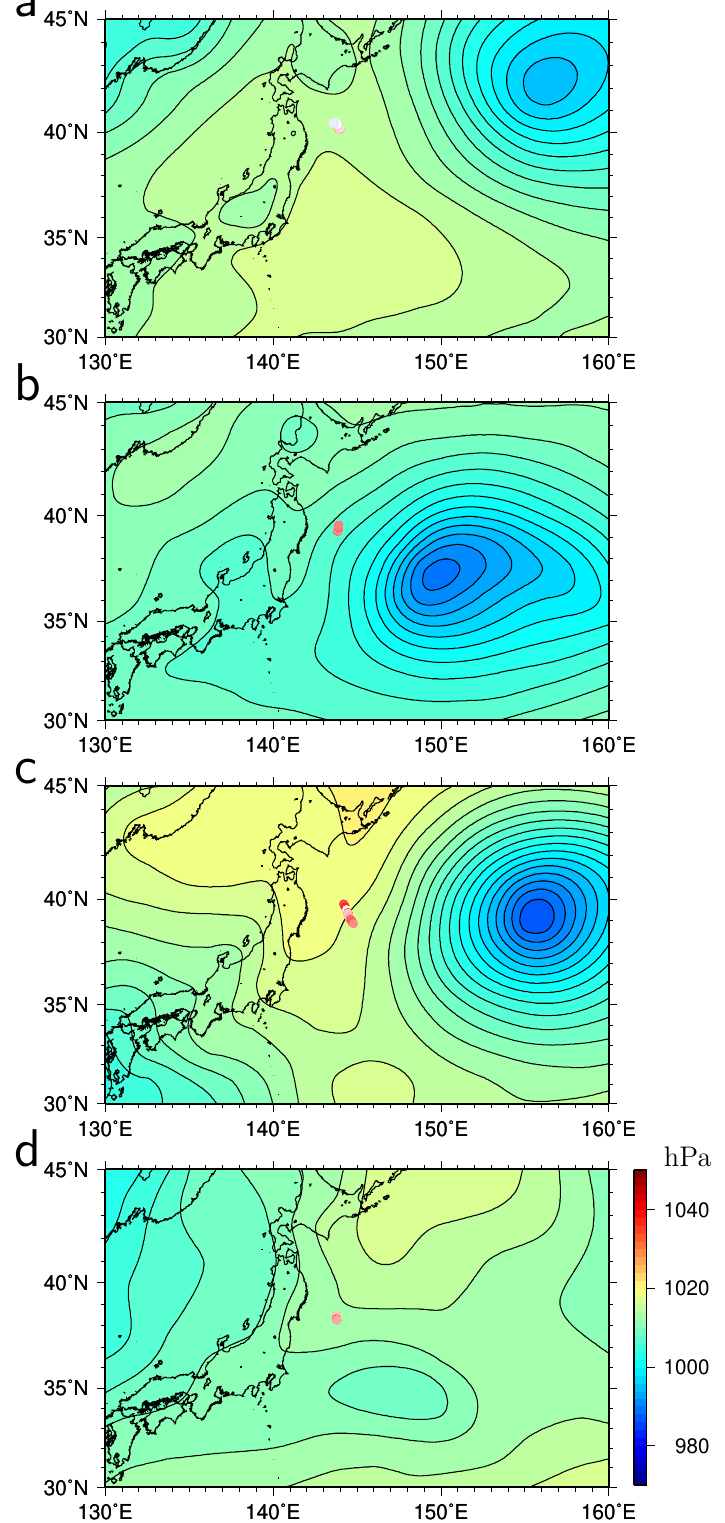
Figure 9. Maps of sea-level pressure (hPa) on ( a ) 24 May, 15:00, ( b ) 7 June, 21:00, ( c ) 13 June, 21:00, and ( d ) 23 June, 03:00, 2022 around the positive peaks of the turbulent (latent plus sensible) heat flux. The contour intervals of sea-level pressure are 2 hPa. The WG tracks around the heat flux peak periods are shown by lines colored by values of heat flux (Wm − 2